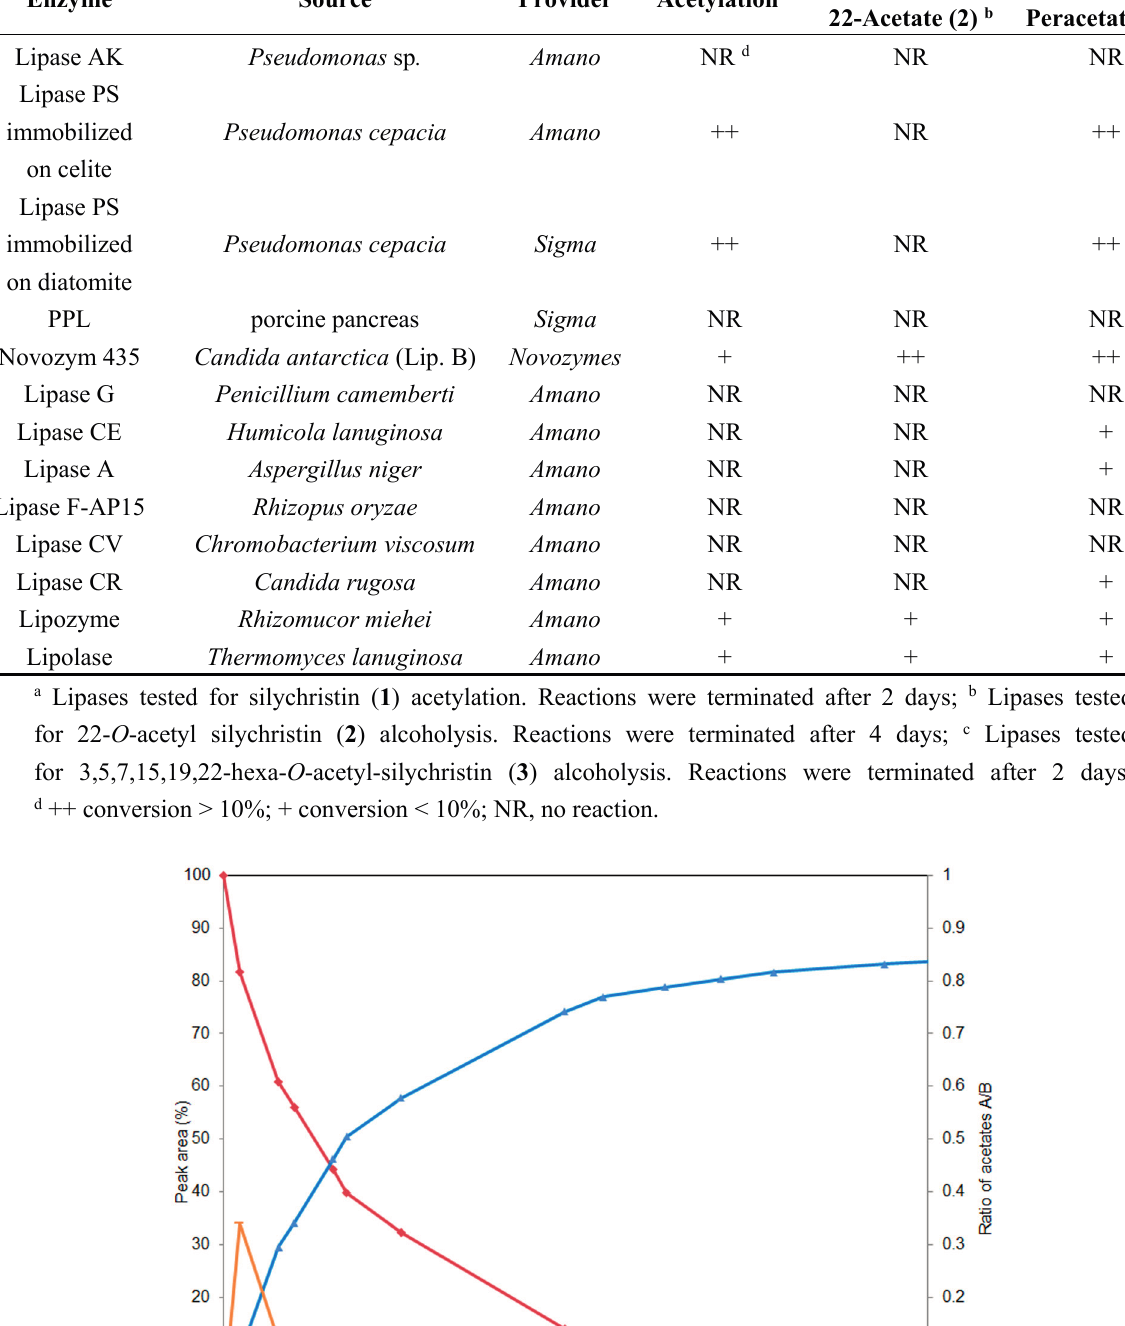
Alcoholysis of Alcoholysis of 22-Acetate (2) b Peracetate (3) c